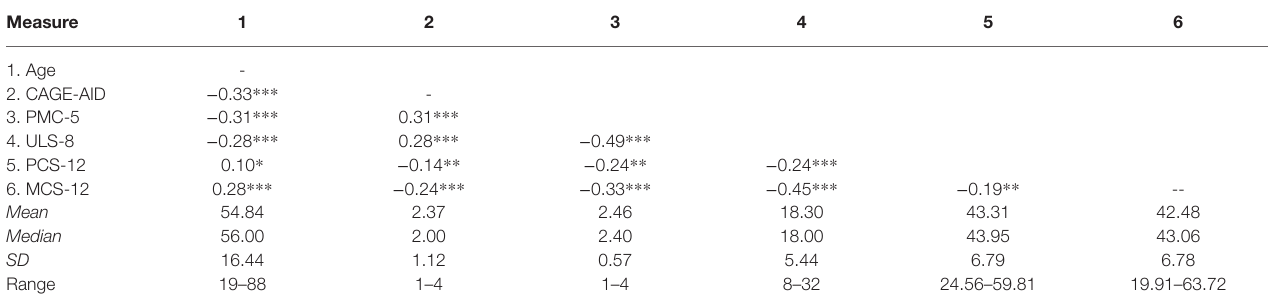
TABLE 5 | Correlations among continuous predictor variables.